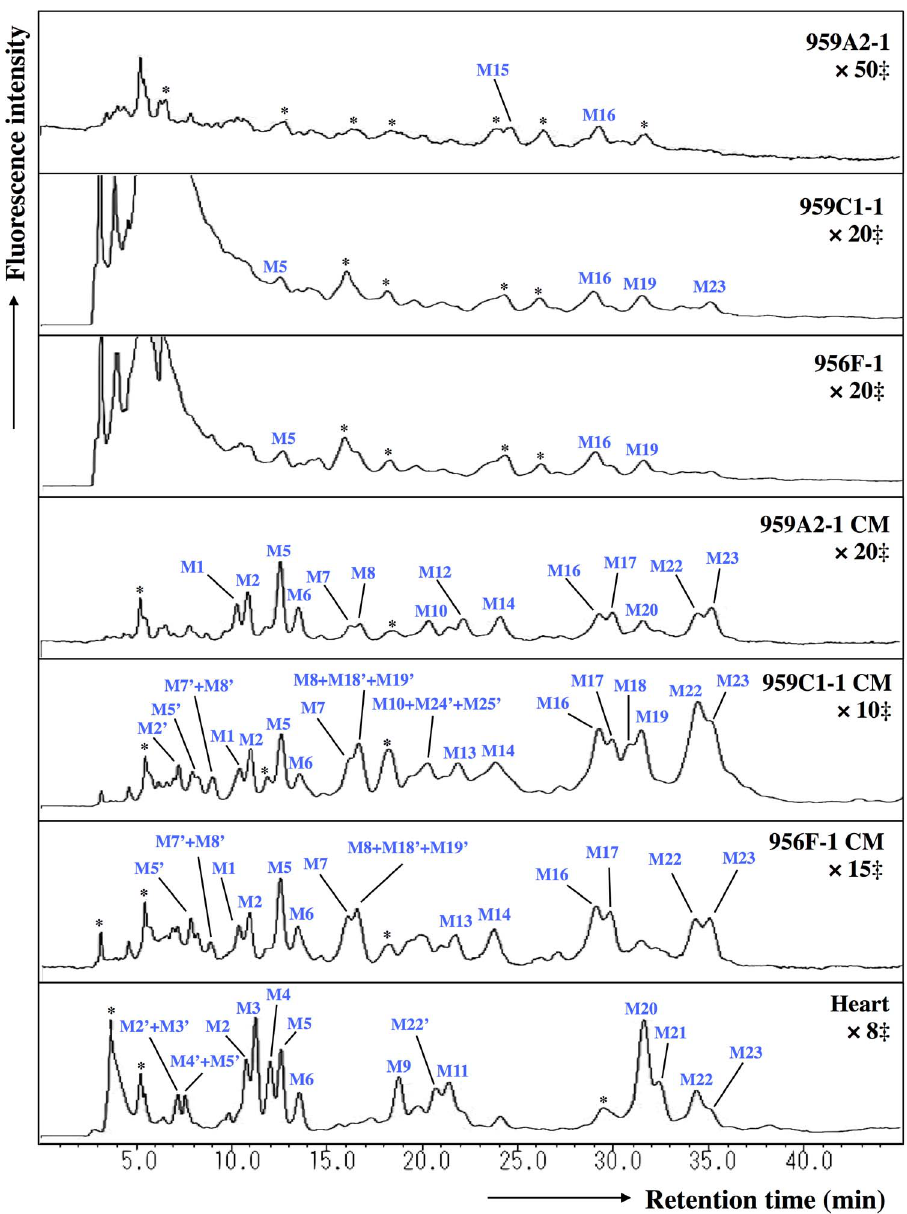
Figure 6. Reverse-phase ODS elution profiles of monosialyl PA-glycans. The monosialyl fractions were individually applied to the ODS column and eluted according to their hydrophobicity. M2 9 , M3 9 , M4 9 , M5 9 , M7 9 , M8 9 , M18 9 , M19 9 , M22 9 , M24 9 and M25 9 : epimerization of M2, M3, M4, M5, M7, M8, M18, M19, M22, M24 and M25. *Fractions containing no detectable PA-oligosaccharides. ` Magnification ratio to the fluorescence intensity of asialoglycan of each sample.